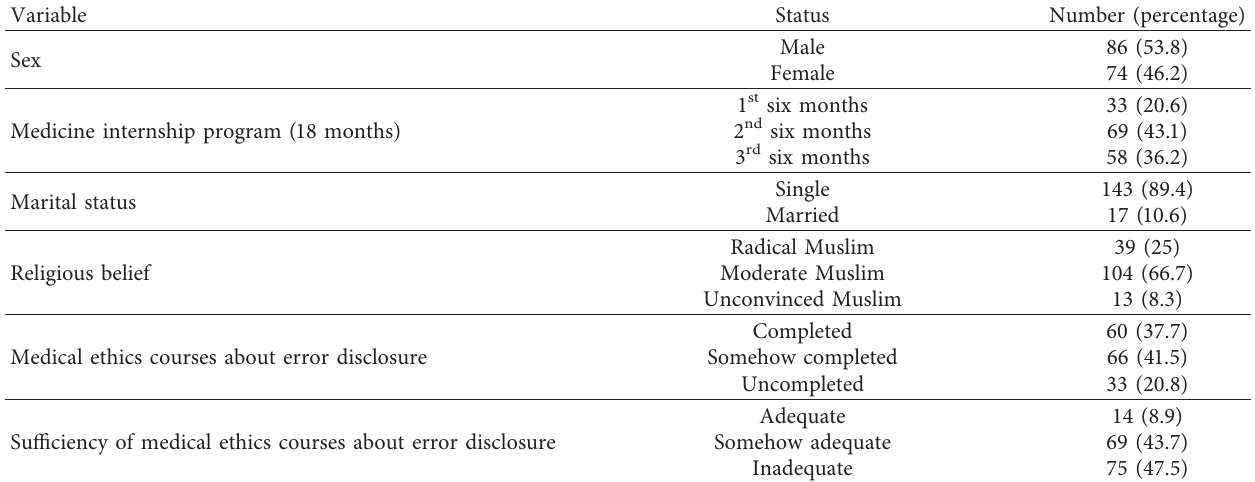
Table 1: Demographic data of the participants.